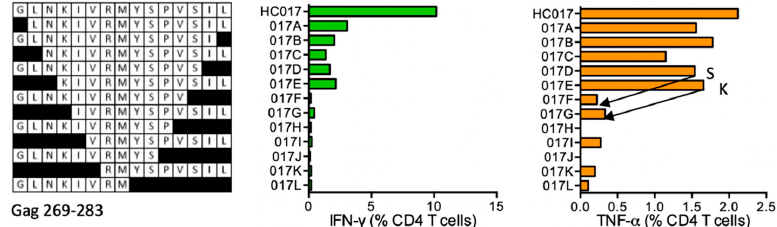
Figure 3. HC017 / VID 418—definition of CD4 + T-cell epitopes in HIV-1 protein Gag. 15-mer-expanded cryopreserved PBMC of volunteer 418 were stimulated with truncated peptides (left) in ICS and production of IFN- γ (green) and TNF- α (orange) by CD4 + T cells was determined. Arrows in the graph and amino acids S and K indicate the stimulatory peptide